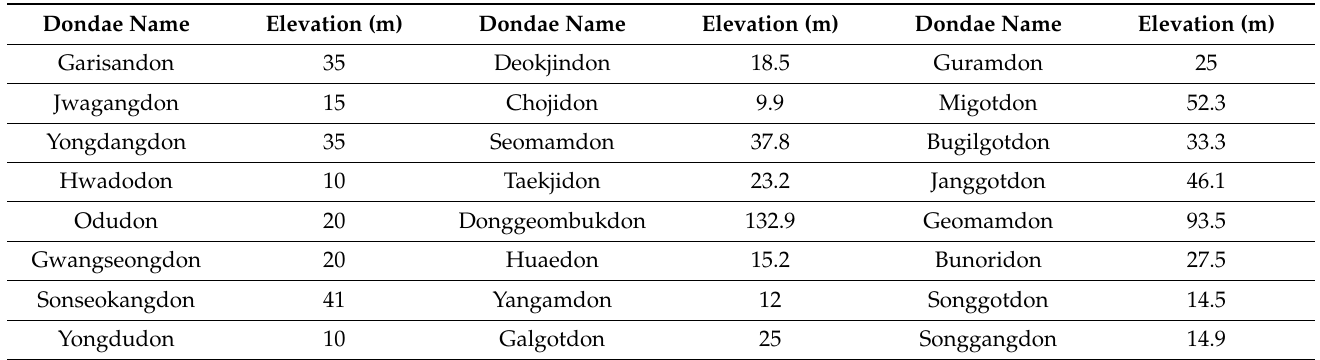
Table 4. Elevation of Ganghwa Dondae fortifications above sea